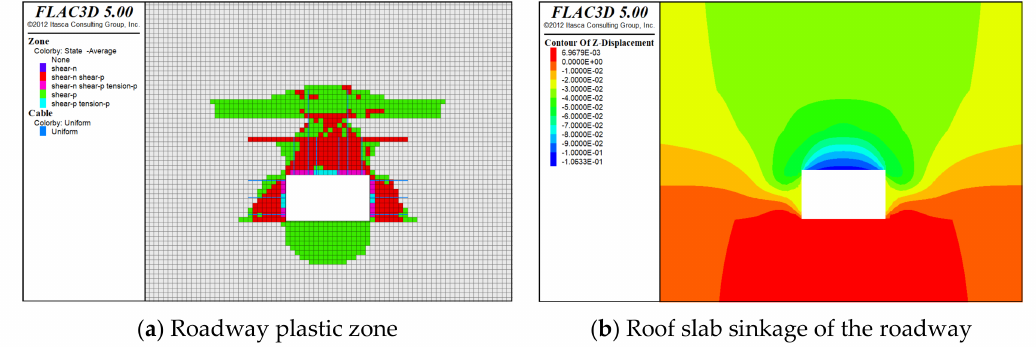
Figure 14. Cloud view of the original support scheme roadway.